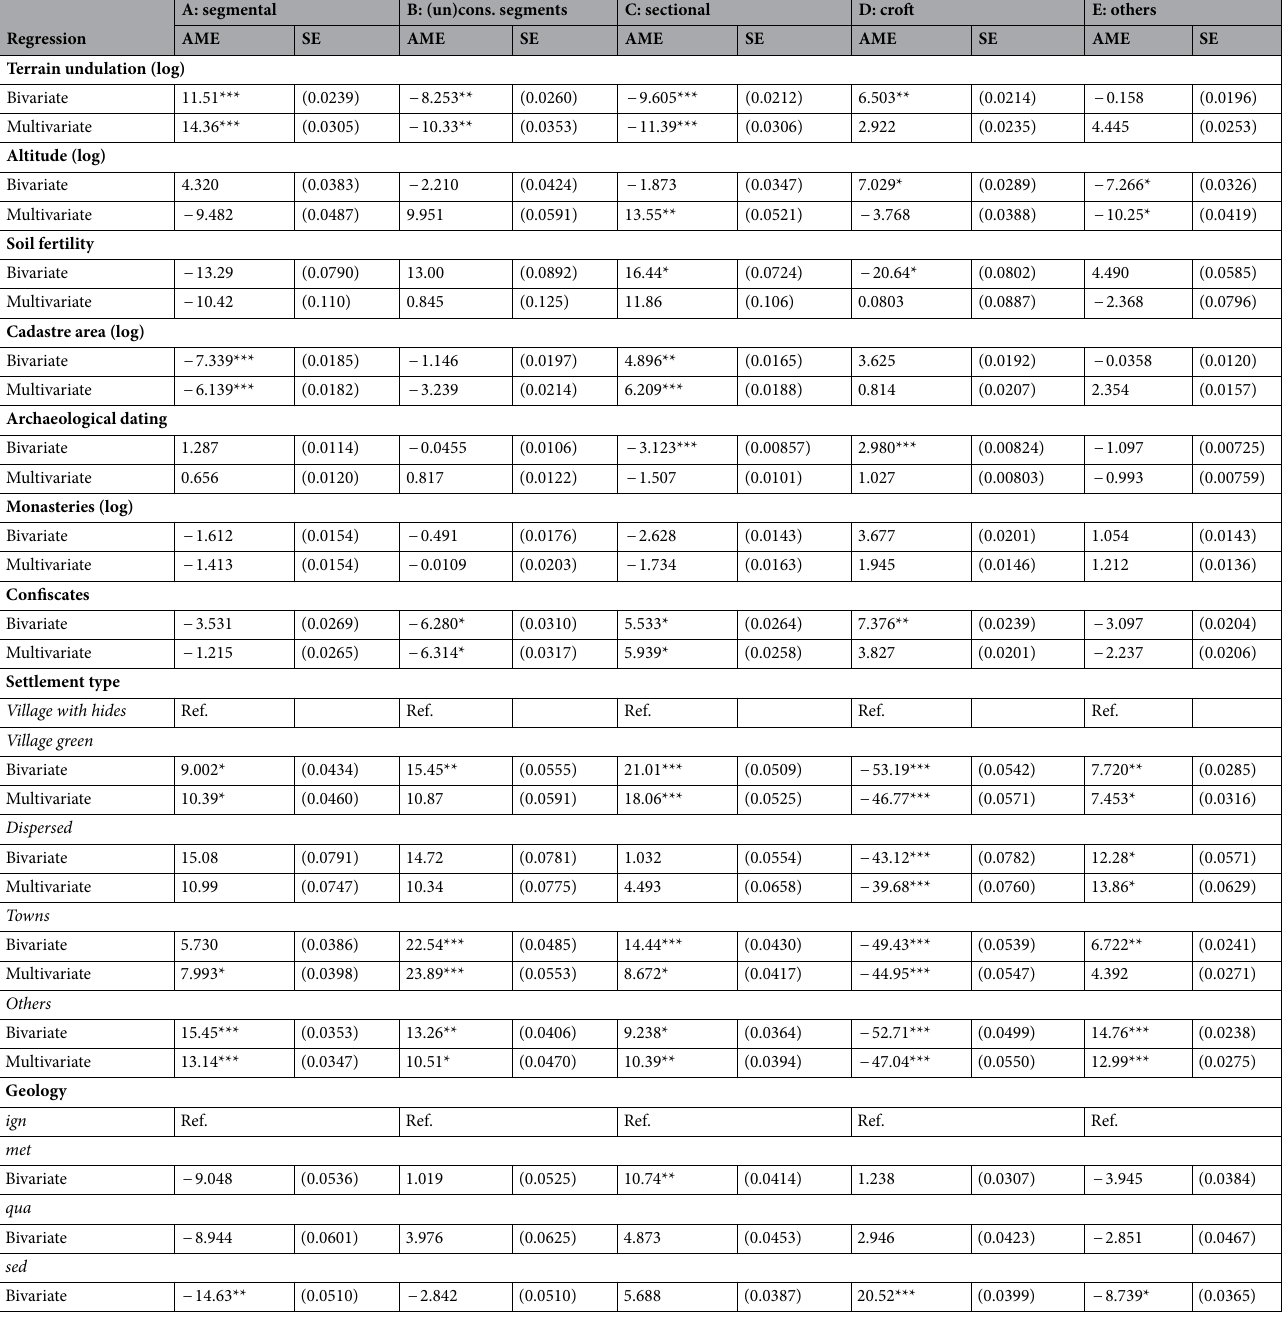
Table 3. Average marginal effects from bivariate and multivariate regressions: fractional multinomial logit explaining the proportions of field patterns. (i) To enhance readability, archaeological date and soil fertility